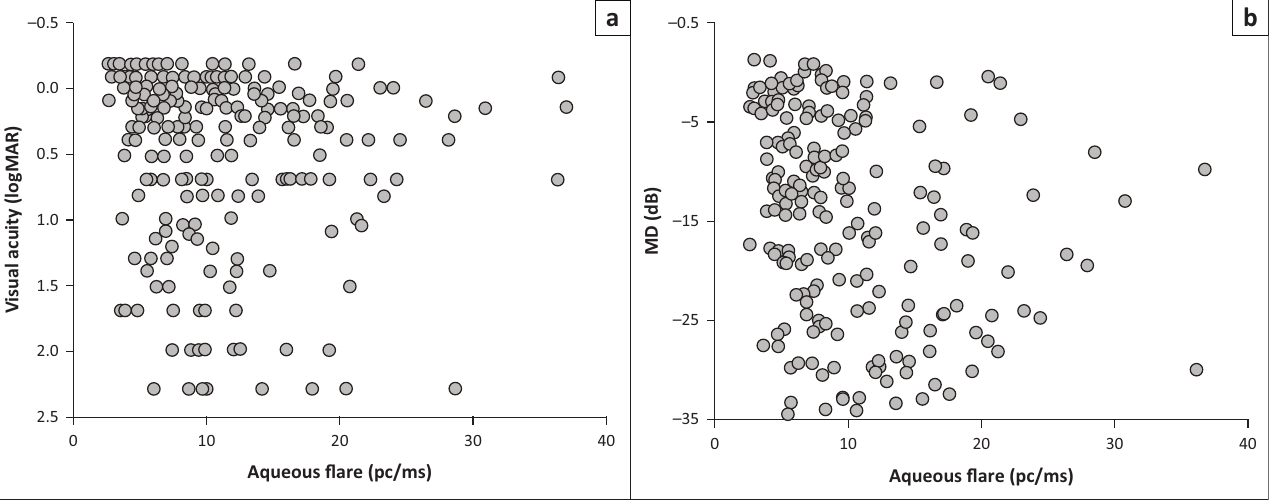
FIGURE 2: (a) Scatterplot illustrating relationship between aqueous flare and central visual function in patients with retinitis pigmentosa ( r = 0.359, p < 0.0001). (b) Scatterplot of aqueous flare values and mean deviation on the Humphrey Field Analyzer 10-2 program ( r = 0.330, p <